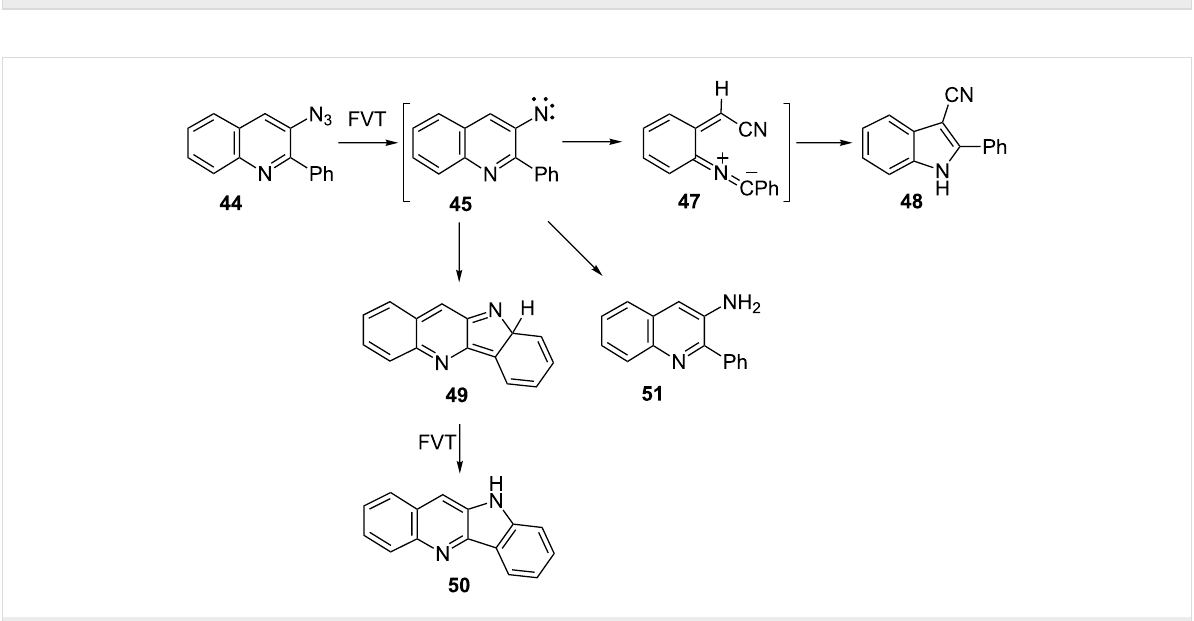
Figure 3: UV–vis spectra from the sequential photolysis of 3-azido-2-phenylquinoline ( 44 ) in Ar matrix at 310–390 nm and 550 nm. Abscissa in nano- metres and ordinate in arbitrary absorbance units. These spectra correspond to the IR spectra in Figure 2. See Supporting Information File 1 for the calculated electronic